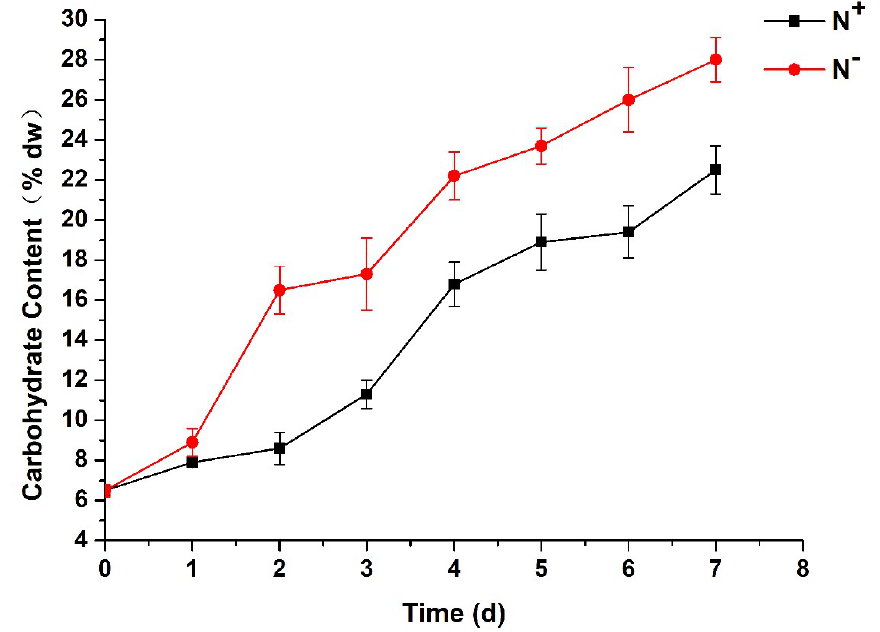
Figure 9. Comparison of total carbohydrate content of Parachlorella kessleri TY02 under N + and N − culture media. Data are shown as mean ± SE. n = 3.